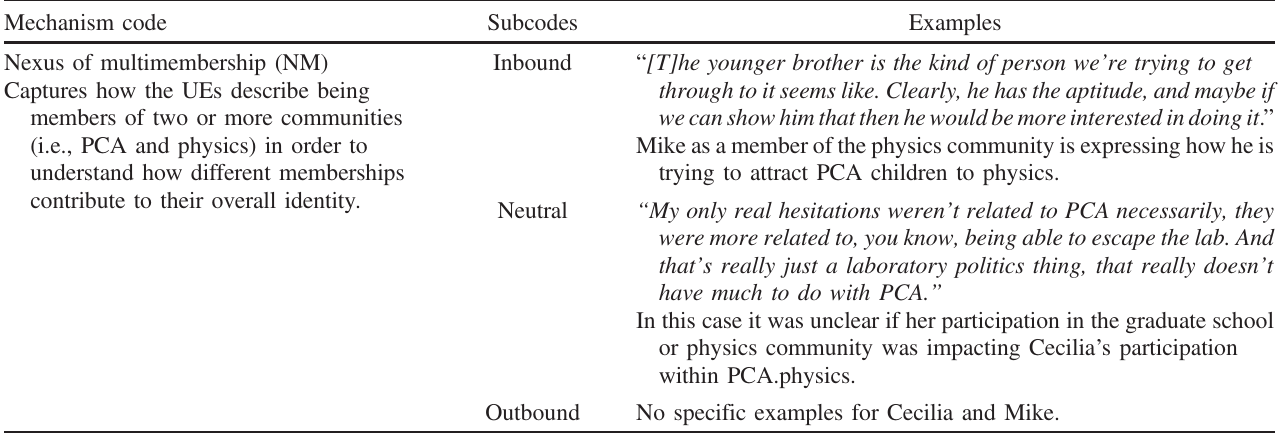
TABLE VIII. Examples and explanations for each subcode under the nexus of multimembership construct.